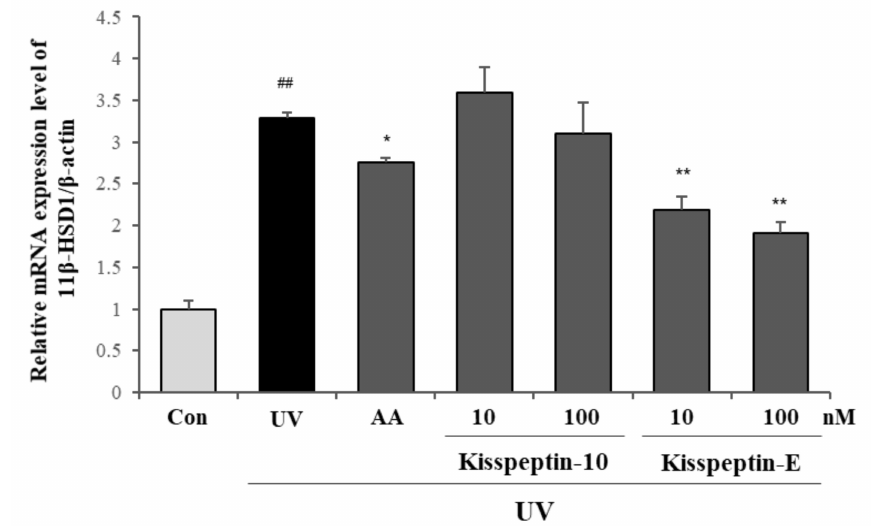
Figure 2. Kisspeptin-mimicking peptides inhibited the mRNA expression of 11 β -HSD1 in UVB-induced Hs68 fibroblasts. Kisspeptin-10 and Kisspeptin-E were treated in UVB-irradiated Hs68 fibroblasts. The mRNA expression level of 11 β -HSD1 was measured by RT-qPCR. The means ± SEs are the average of three independent experiments. AA, Ascorbic acid; ## p < 0.01 indicates a significant di ff erence from the control. * p < 0.05 and ** p < 0.01 indicate a significant di ff erence from the UVB-induced